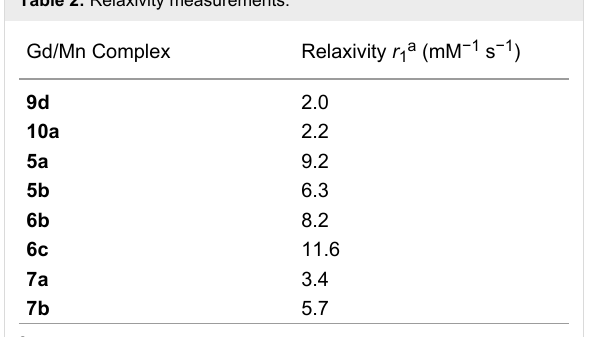
Table 2: Relaxivity